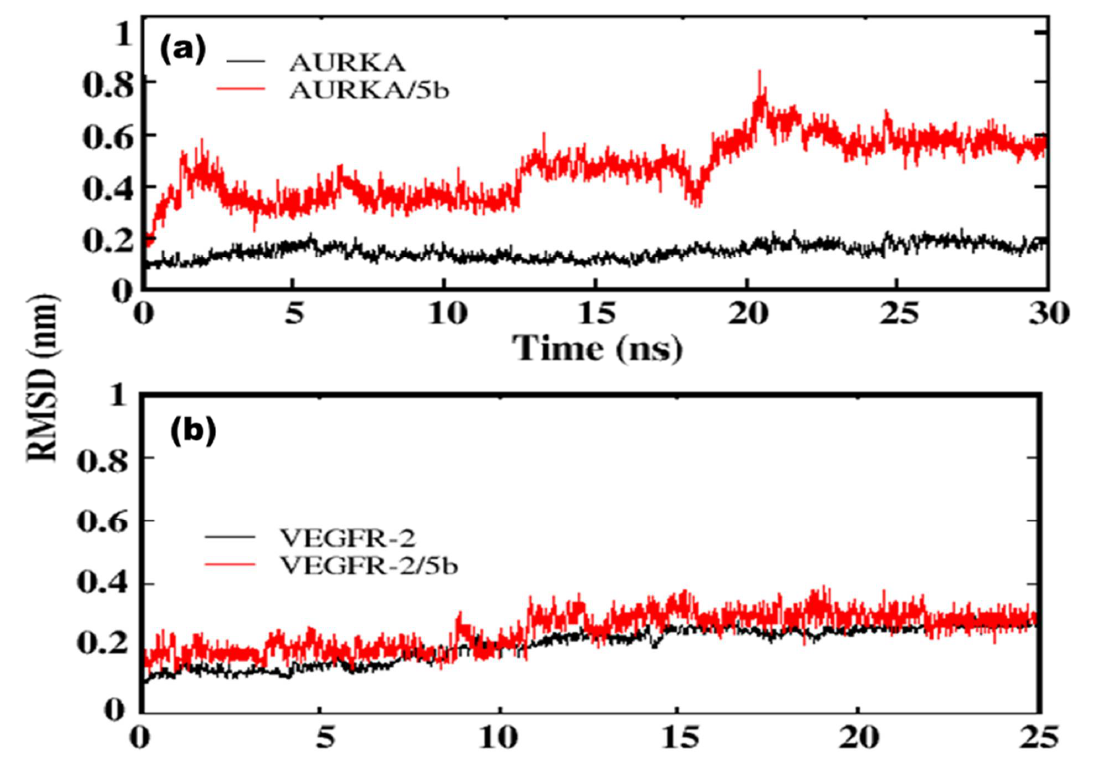
Figure 2. RMSD profile of backbone C α atoms of protein (black) and ligand concerning protein (red) during the course of simulation ( a ) AURKA and ( b ) VEGFR-2.